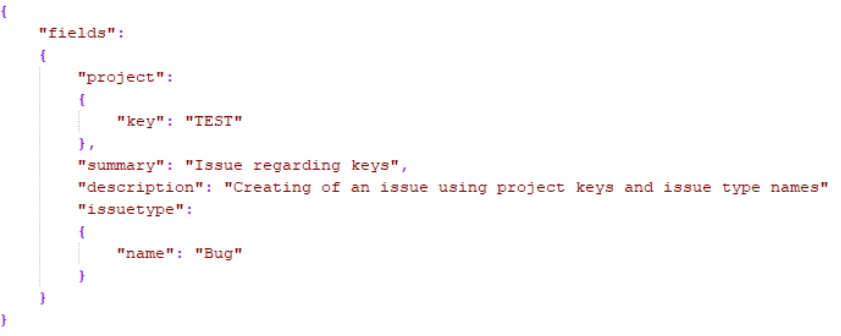
Figure 5. Jira input data.